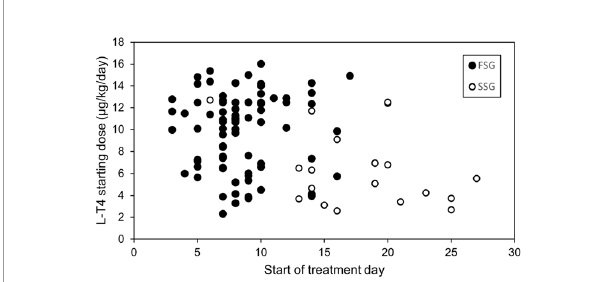
FIGURE 2 | Start of the treatment day and levothyroxine starting dose in the fi rst (FSG) and the second (SSG) screening groups.